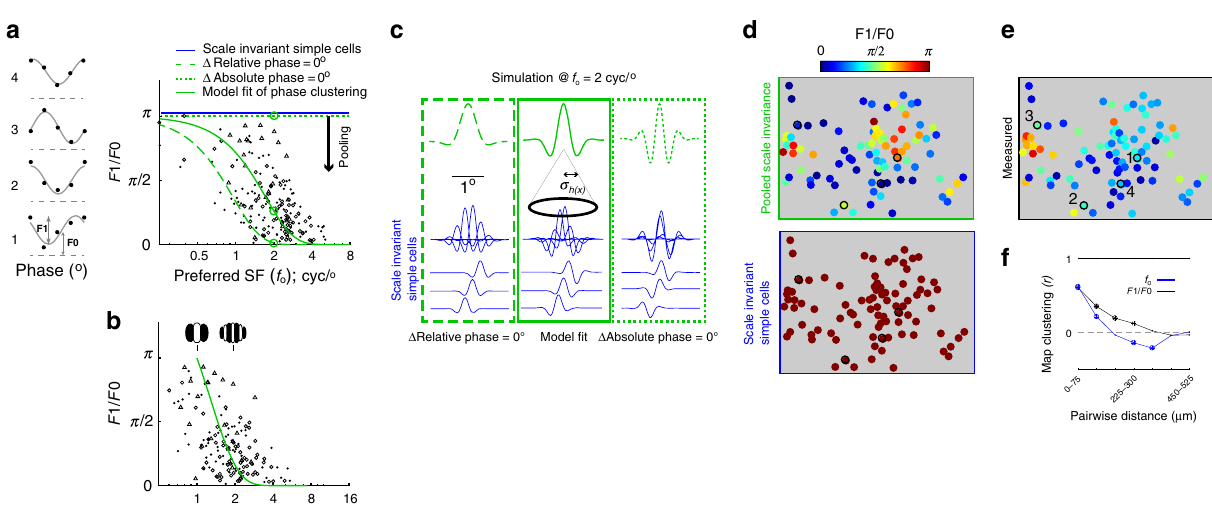
Fig. 4 Phase selectivity as a function of preferred SF ( f o ). a Scatter plot compares f o to F 1/ F 0 from three ROIs, each indicated by a different symbol. See Table 2 for joint statistics. Each of the three green curves show the result of pooling from the same population of scale invariant simple cells, and the same retinotopic integration window ( σ h ( x ) = 0.24°; determined in Fig. 3), but with different alignment in the absolute phase. The solid green curve is the least- squares fi t of phase alignment to the data. To the left of the y -axis are phase tuning curves (black) and fi ts (gray) of four example neurons in one ROI outlined and enumerated in e . b Like the scatter plot in a , y -axis data points are F 1/ F 0. However, the x -axis is converted into a metric for the deviation from scale invariance. Speci fi cally, it is the measured RF width divided by the scale invariance prediction of RF width. To obtain the domain of the green curve, we took the following ratio: pooled scale invariance prediction of RF width (Eq. (5)) over the scale invariance prediction of RF width (Eq. (1)). Gabor insets illustrate how the number of ON/OFF sub fi elds increase along the x -axis. c Simulation of the pooling model in the spatial domain at f o = 2 cyc/°, for the three examples of phase alignment plotted in a (see green open circles in a ). At bottom in blue are the 1D Gabor functions from the model of scale invariance. The spatial phase progresses at a different rate, inside each of the three green rectangles. In the left example, “ relative phase ” does not change, whereas in the right example “ absolute phase ” does not change. Just above, also in blue, are the Gabor functions weighted according to the Gaussian in the pooling model ( σ h ( x ) = 0.24°). The top green curves are the superposition of scale invariant inputs, where the constant absolute phase (right) yields the greatest phase modulation. d Maps of F 1/ F 0. Bottom panel is all simple cells ( F 1/ F 0 = π ) and is the input to the scale invariant pooling model. Top panel is the output of scale invariant pooling, based on the solid green fi t to the data in a . e Measured map of F 1/ F 0. f Pearson correlation coef fi cient between neuronal pairs, within 75 μ m cortical distance bins, using all three ROIs in the study. The symbol at each distance bin indicates the correlation coef fi cient ’ s signi fi cance: Closed dot is p > 0.01, asterisk is p < 0.01, asterisk and open circle is p <